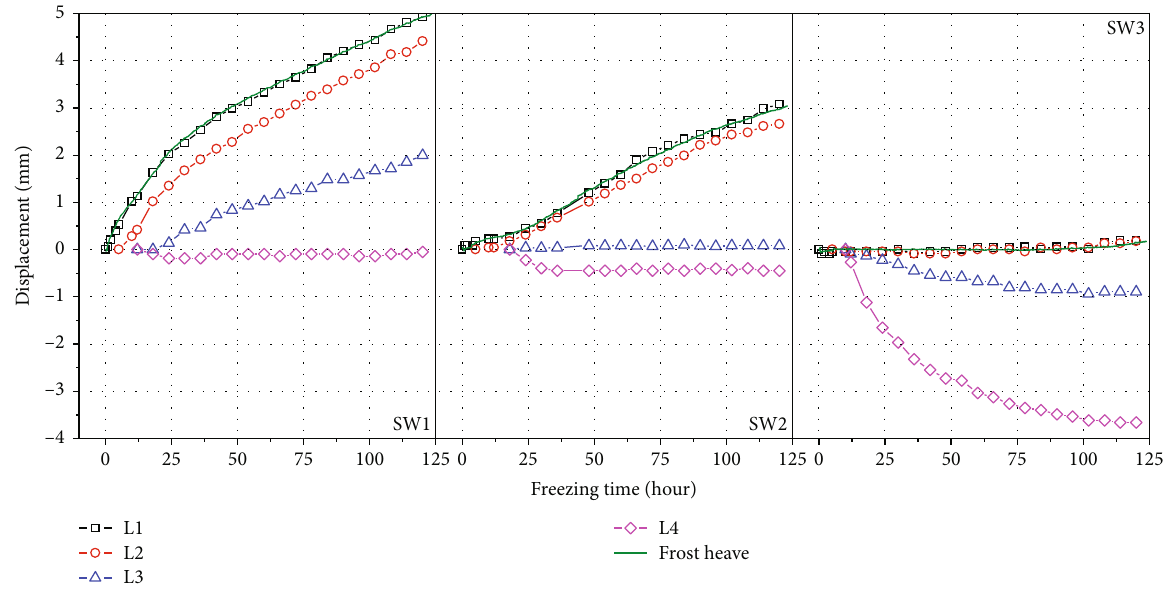
Figure 8: Frost heave and the displacement process of the boundary lines of the cryostructure areas in the samples SW1, SW2, and